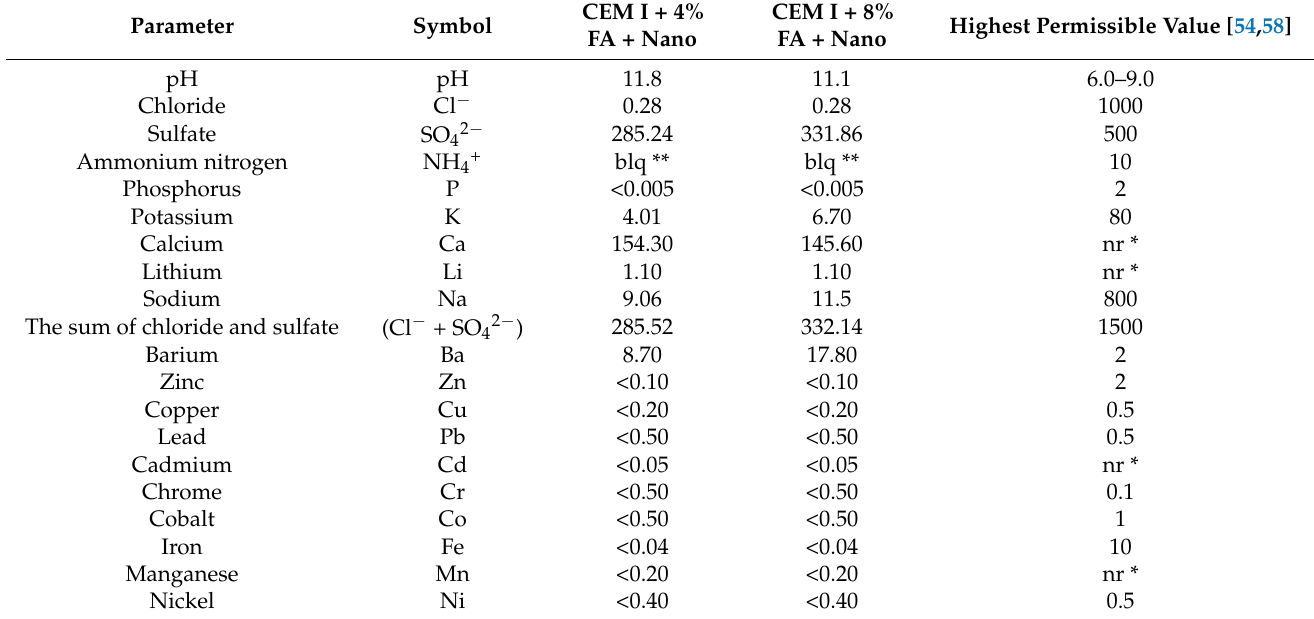
Table 6. Leachability of hazardous substances and heavy metals from cement mortars with the addition of fly ash modified with nanosilica, expressed in